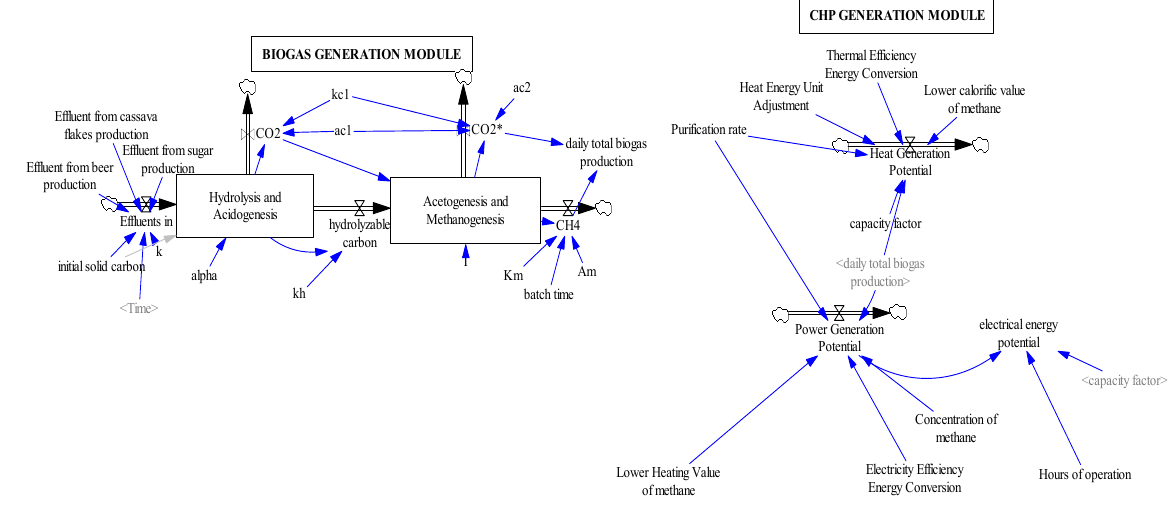
Figure 4. System dynamics biogas energy recovery model for CHP.